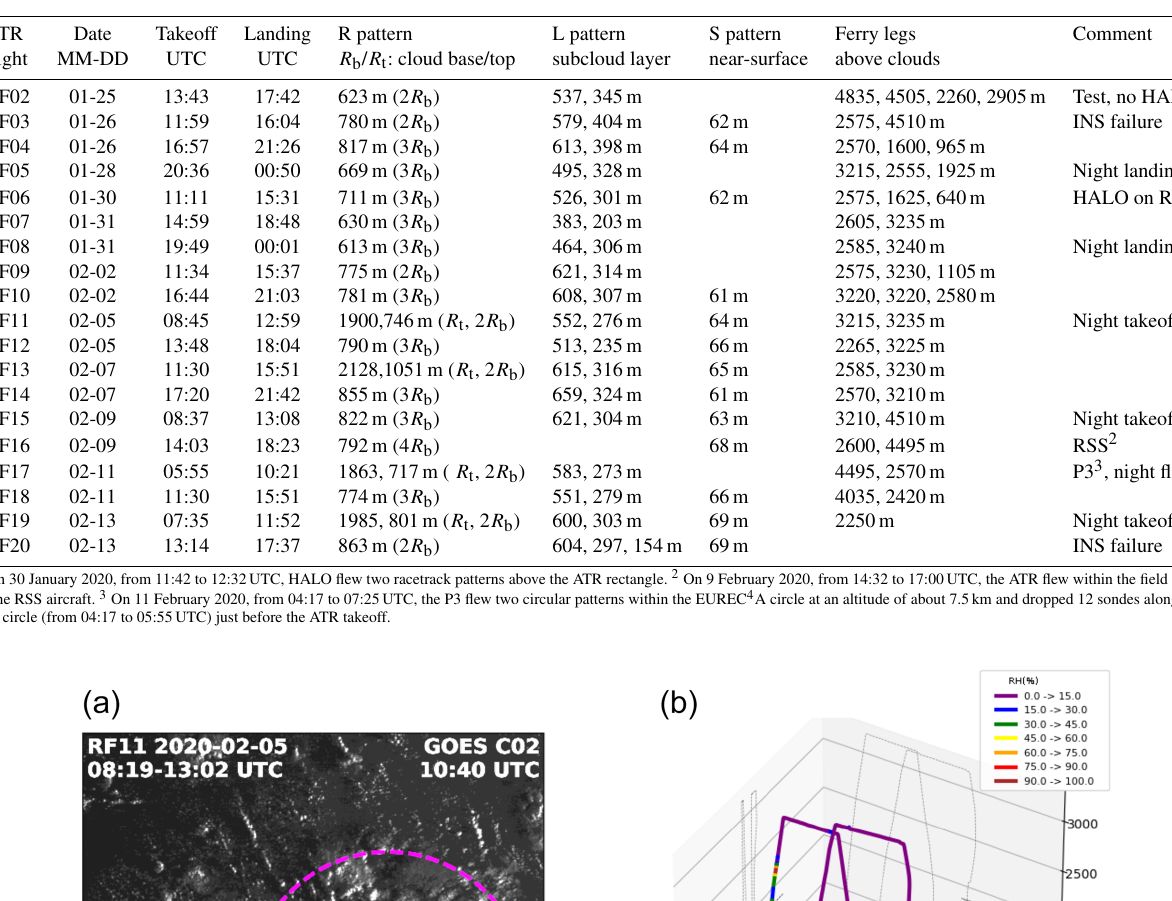
Table 1. List of ATR flights with a brief description of the main flight patterns: the mean approximate height (and number) of rectangles flown around cloud base ( R b ) or cloud top ( R t ), the height of the L patterns flown near the top and the middle of the subcloud layer, the height of the near-surface leg (S pattern) and of the ferry legs flown above clouds.